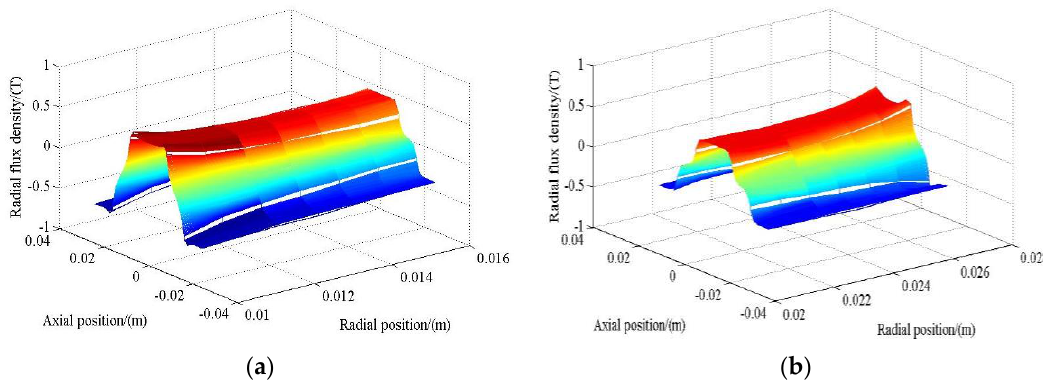
Figure 9. Magnetic flux density with respect to axial and radial directions: ( a ) Inner winding region; ( b ) Outer winding region.